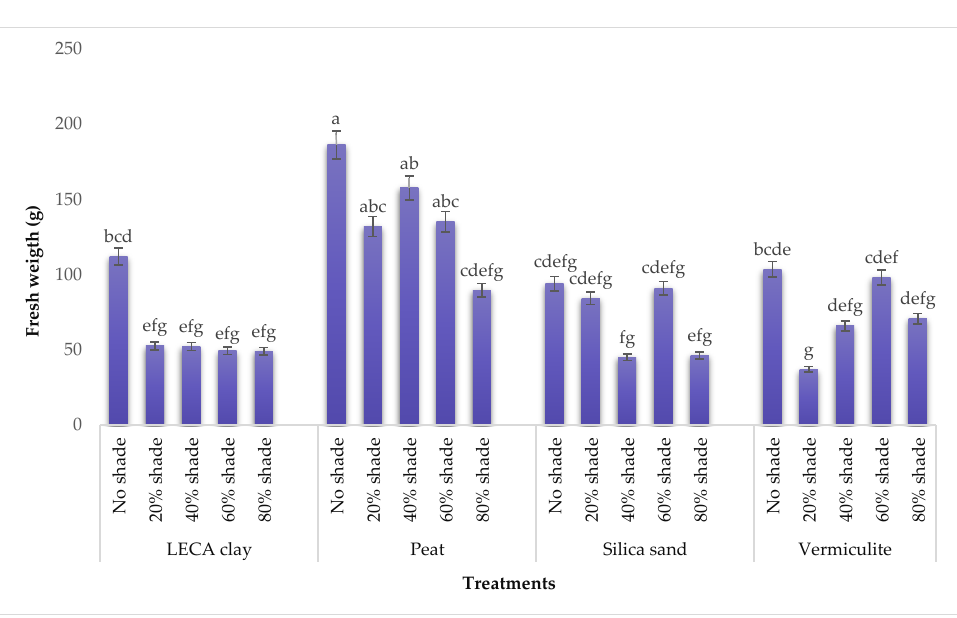
Figure 3. The effect of different growth media and shade levels on the formation of buds of T. divaricata . Means followed by the same letter do not differ significantly by Tukey’s test ( p ≤ 0.05). 3.1.2. Total Fresh and Dry Weight of T. divaricata Weight of fresh and dry T. divaricata varied significantly between treatments (Figure 4).